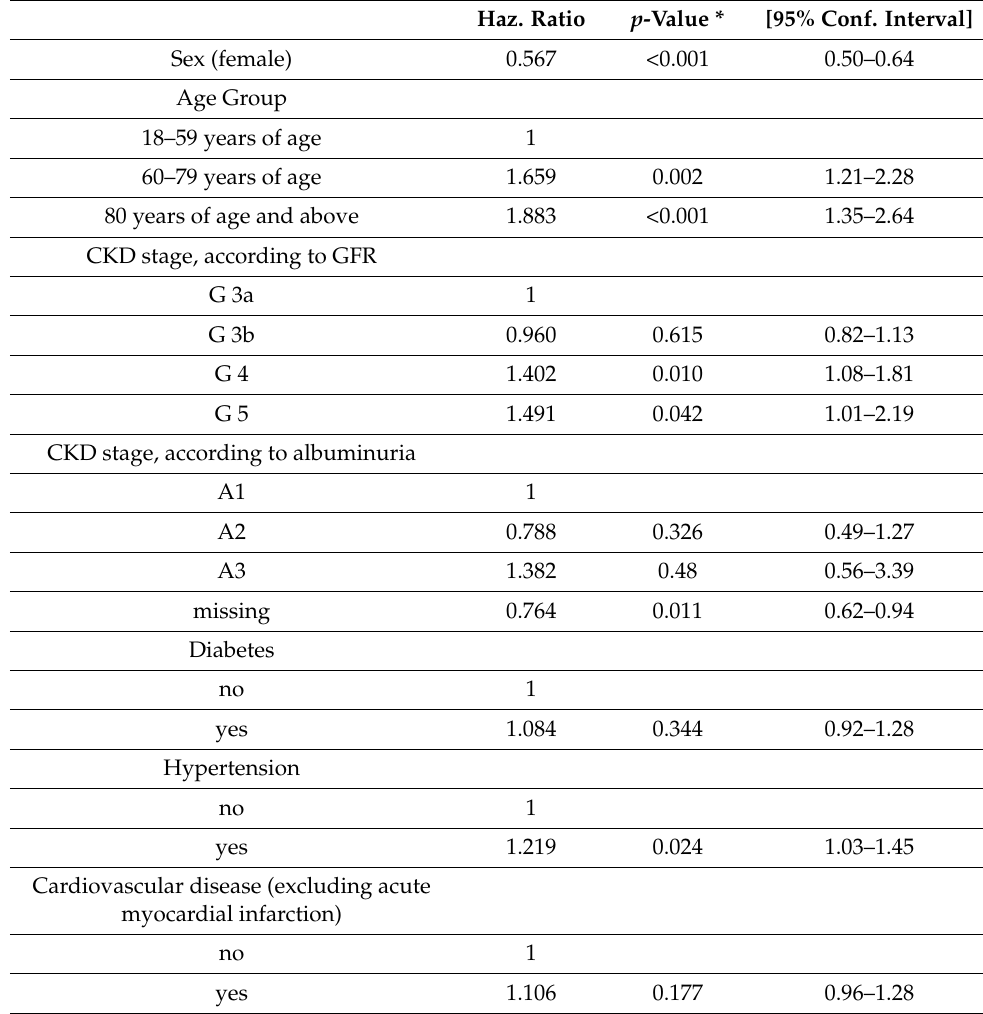
Table 2. Hazard ratio of AMI during 5-year follow-up in CKD G3–5 patients without prior